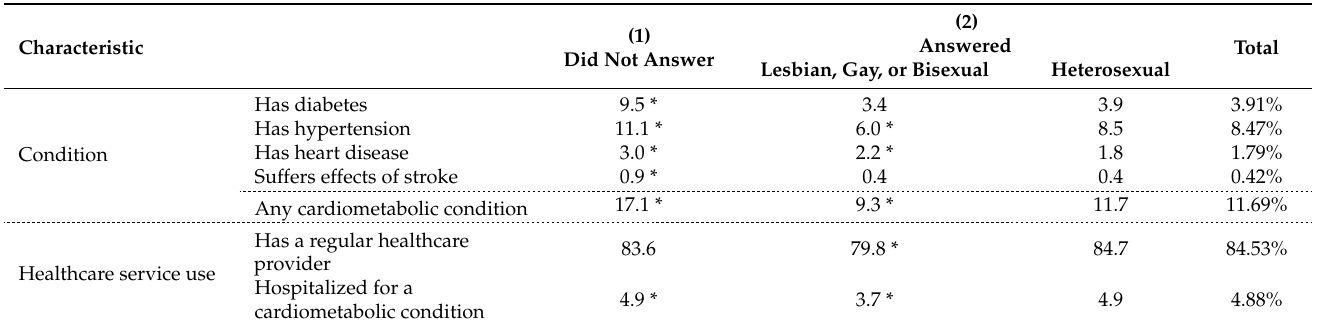
Table 3. Proportion (%) of survey respondents aged 18–59 with cardiometabolic conditions and healthcare service use, according to their response to the question on sexual